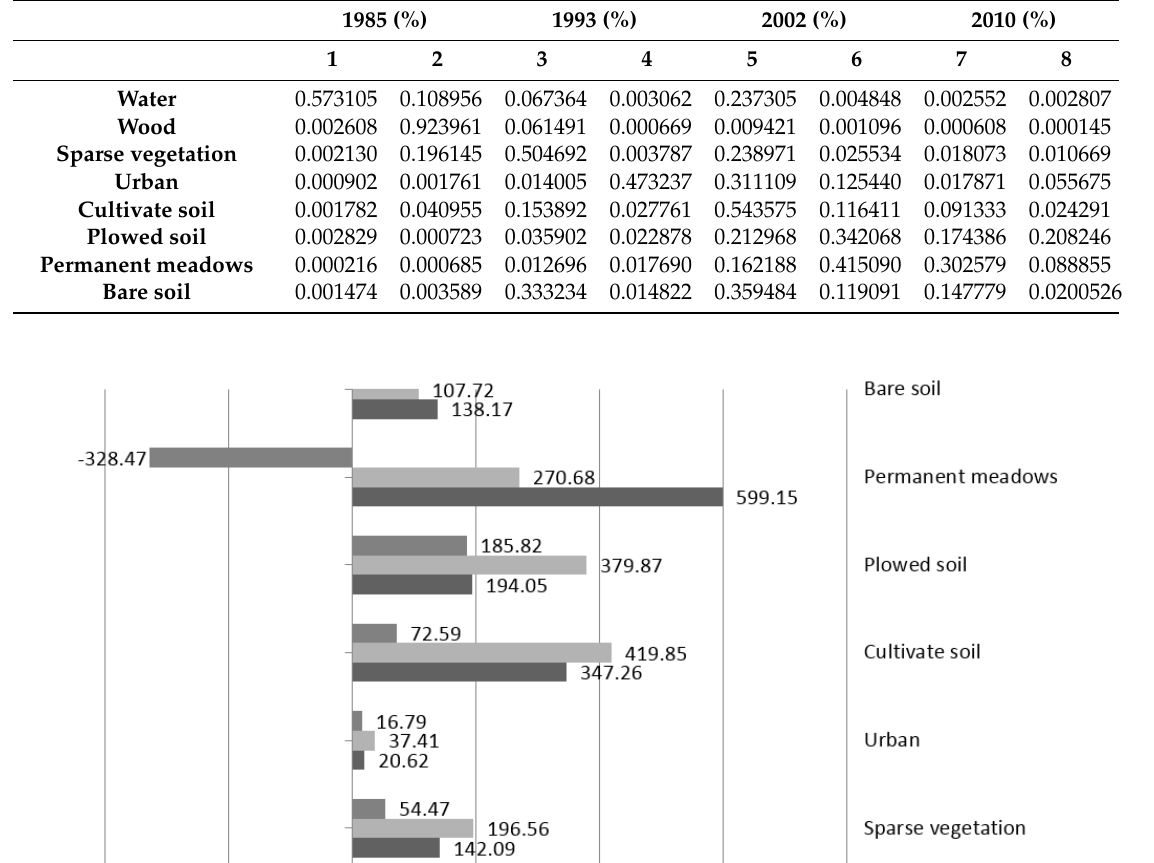
Table 5. Transition matrix of objects classified in 1985 and 2010.